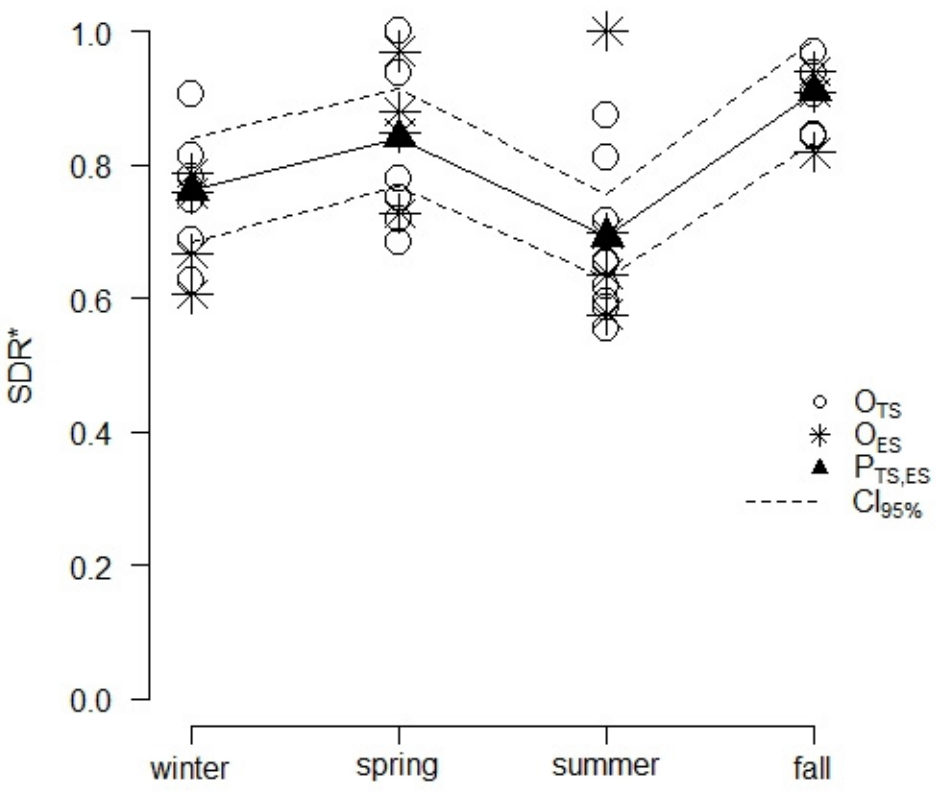
Figure 3. Results from the cosine regression modelling of the average SDR of Cryphonectria parasitica over the baseline of 60 propagules · m − 2 · h − 1 (SDR*) as a periodic function of the season. Points mark the average SDR* observed during the 4 seasons in TS (O TS ) and ES (O ES ) or the average SDR* values predicted by the model for the TS and ES sites (P TS,ES ) with the related 95% confidence intervals (CI 95% ). Observed SDR* values refer to each sampling whose corresponding DR was larger than 60 propagules · m − 2 · h − 1 , while predicted SDR* results are the outcomes of the cosine regression model. Segments are used to link dots related to model predictions, highlighting the periodic seasonal fluctuation of the